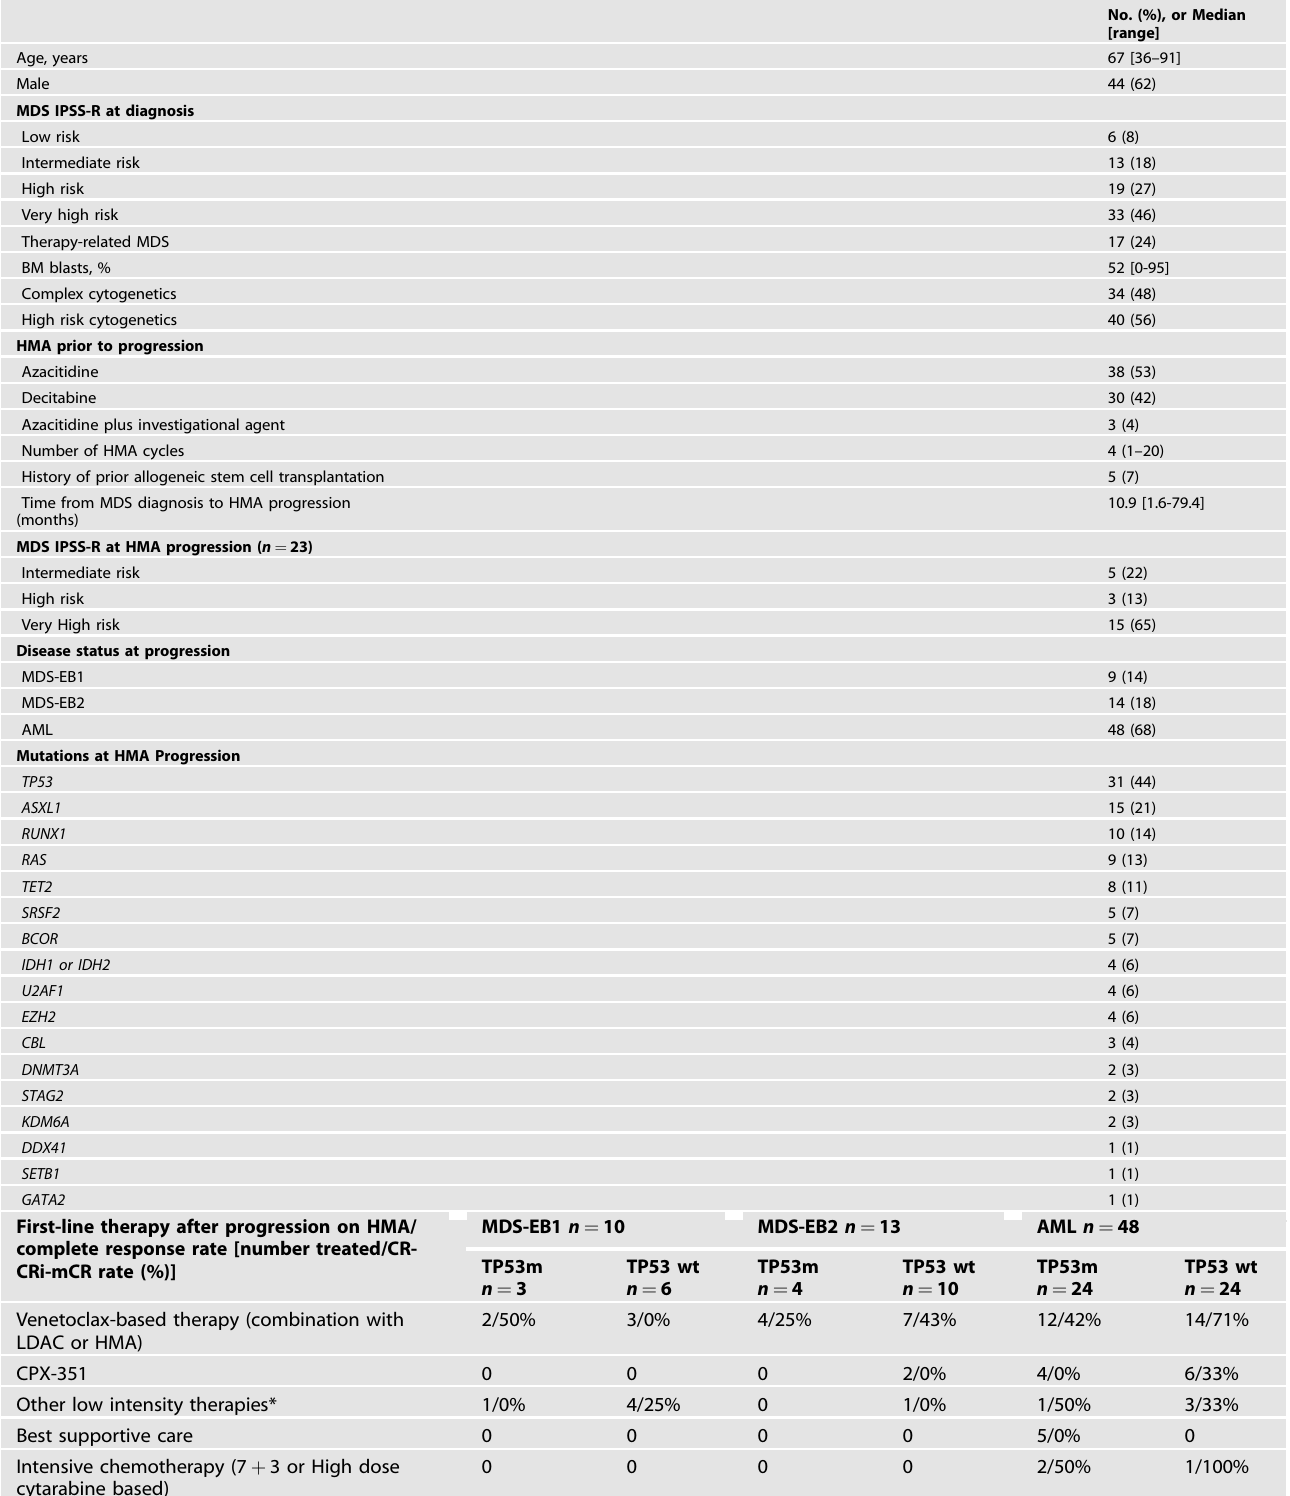
Table 1. Baseline characteristics, treatment, and